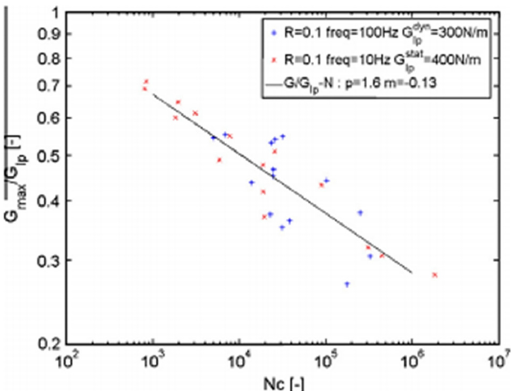
Figure 18. G–N propagation curve on G Ip for 10 Hz and 100 Hz [52].